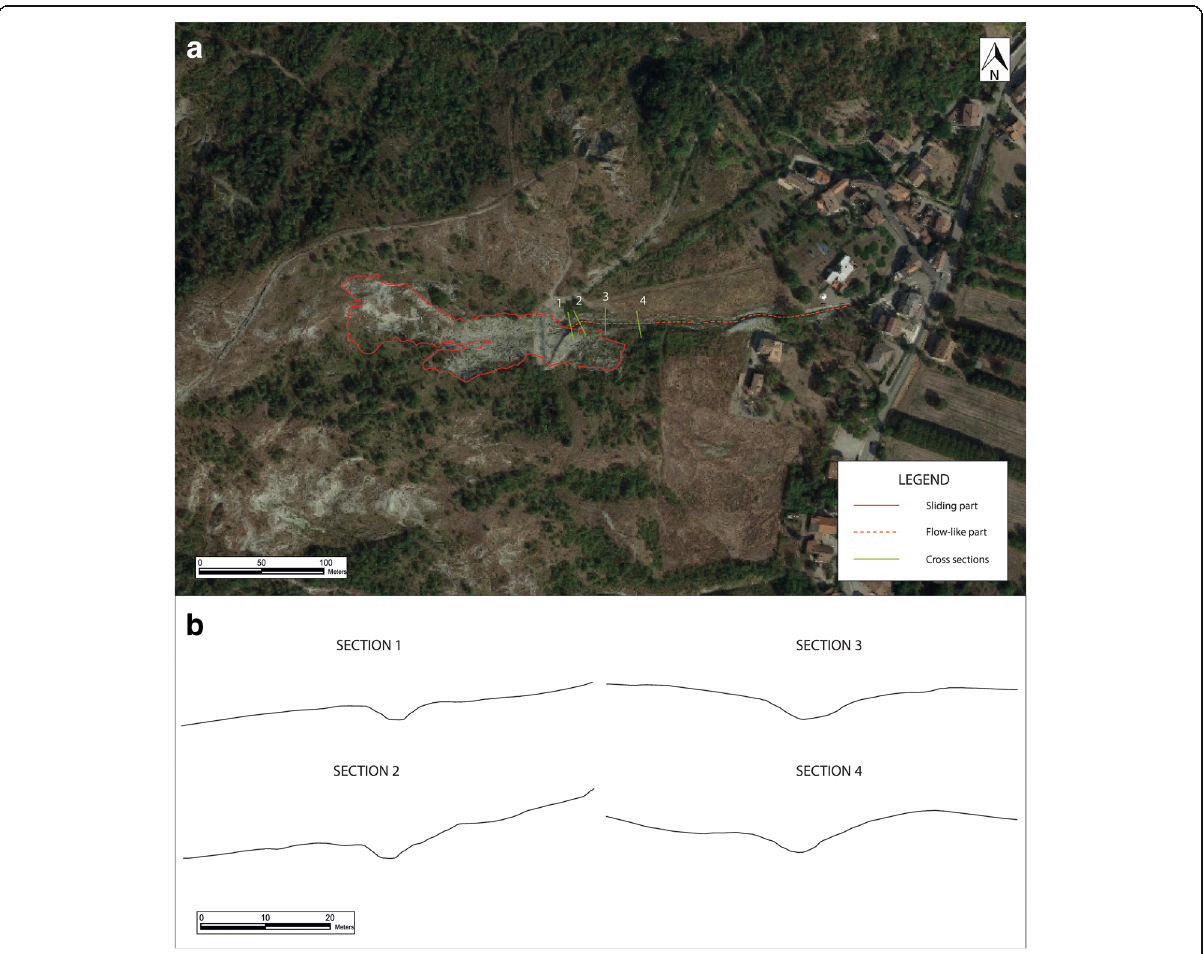
Fig. 8 Location of the cross sections for flow velocity estimation. a ) Location of the cross sections for flow velocity estimation and b ) Sections